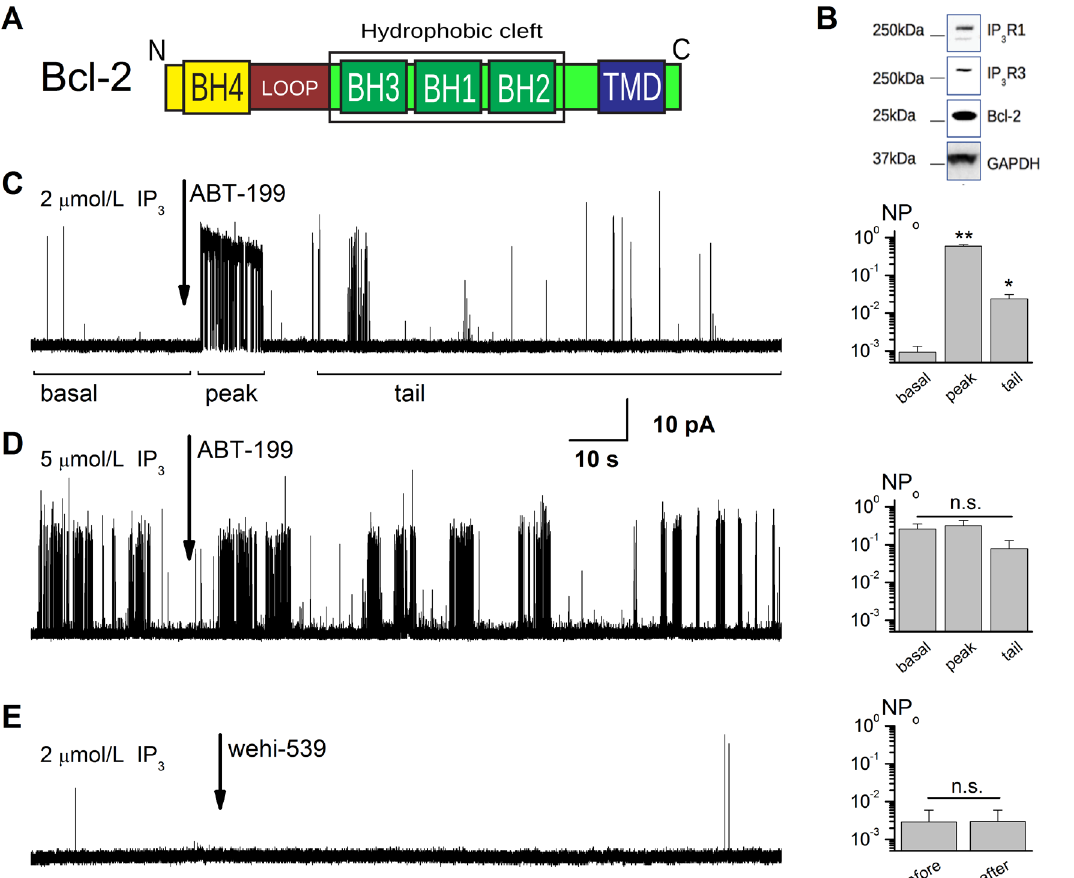
R in conditions of low channel activity. (A). A schematic representation Figure 1. ABT-199 disturbs the Bcl-2-dependant inhibition of IP 3 of the Bcl-2 subunit composition. Letters N and C mark the N- and C-terminal ends of the protein. (B). Expression levels of IP R1, 3 IP R3, and Bcl-2 proteins are illustrated by western blot (WB) analysis of the ER fractions from the Bcl-2 overexpressing WEHI7.2 3 cells. (C, D). Sample traces showing the effect of application of 1 µmol/L ABT-199 to the patches exhibiting IP R activity stimulated 3 by 2 µmol/L (C) and 5 µmol/L (D) IP . Notice the complex nature of the IP R activity at characteristic open probability (P ) in panel 3 3 o C, with principal regions indicated by horizontal bars marking the regions of “basal”, “peak” (acute ABT-199 effect), and